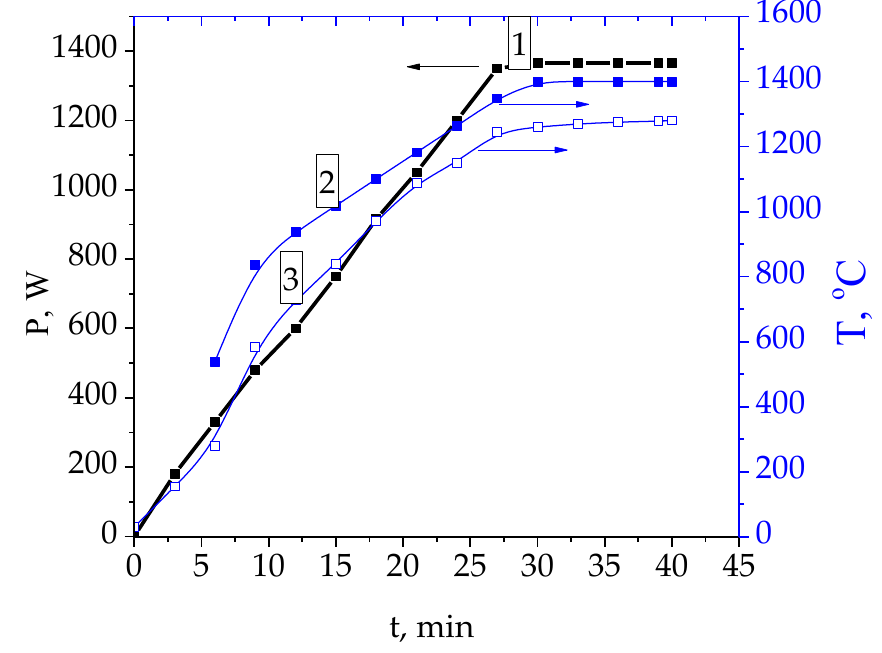
Figure 2. Dependencies of the electron beam power 1 and the temperature of irradiated 2 and non-irradiated 3 surfaces of the 75A composite, as a function of time.